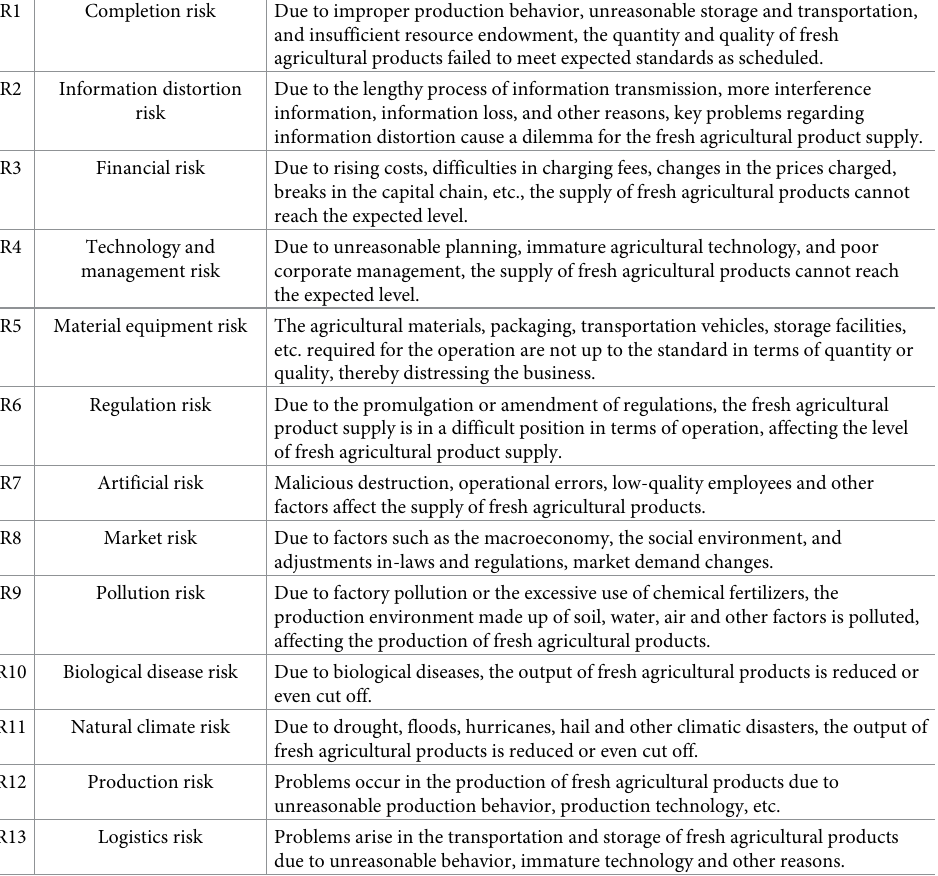
Table 1. Risk factors of the fresh agricultural product supply.